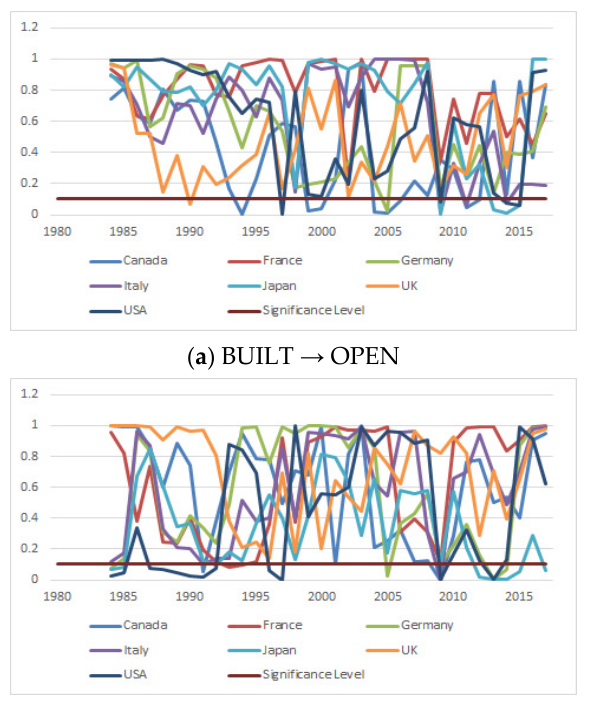
Figure 2. The results of the asymmetric panel causality test for positive shocks.